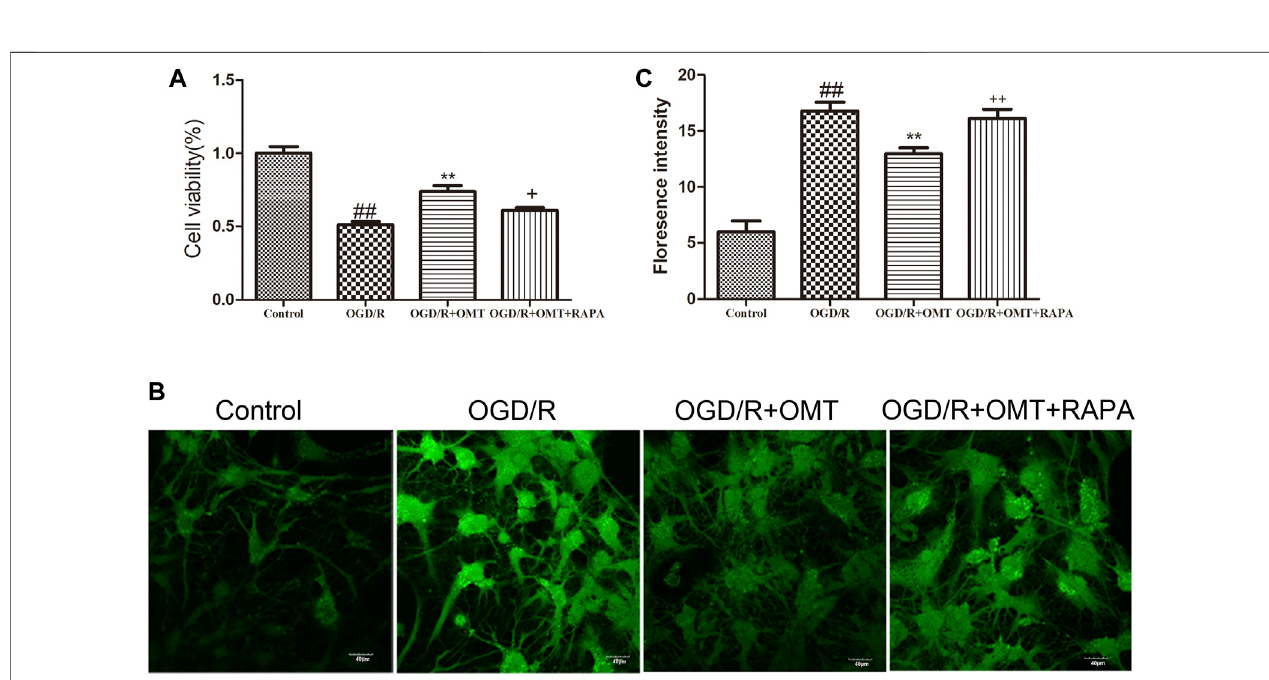
FIGURE3 | Assessments ofneuronaldeath and level of intracellular mitochondrial permeability transition pore(mPTP) in the primary hippocampal neurons at 24 h after oxygen-glucose deprivation reperfusion (OGD/R). (A) Cell viability assay. (B) Fluorescence micrographs of mPTP. (C) mPTP assay. The results are expressed as mean ± SEM ( n (cid:1) 6 per group). ## p < 0.01 vs. the sham group; ** p < 0.01 vs. the HI group; and + p < 0.05, ++ p < 0.01 vs. the oxymatrine (OMT)